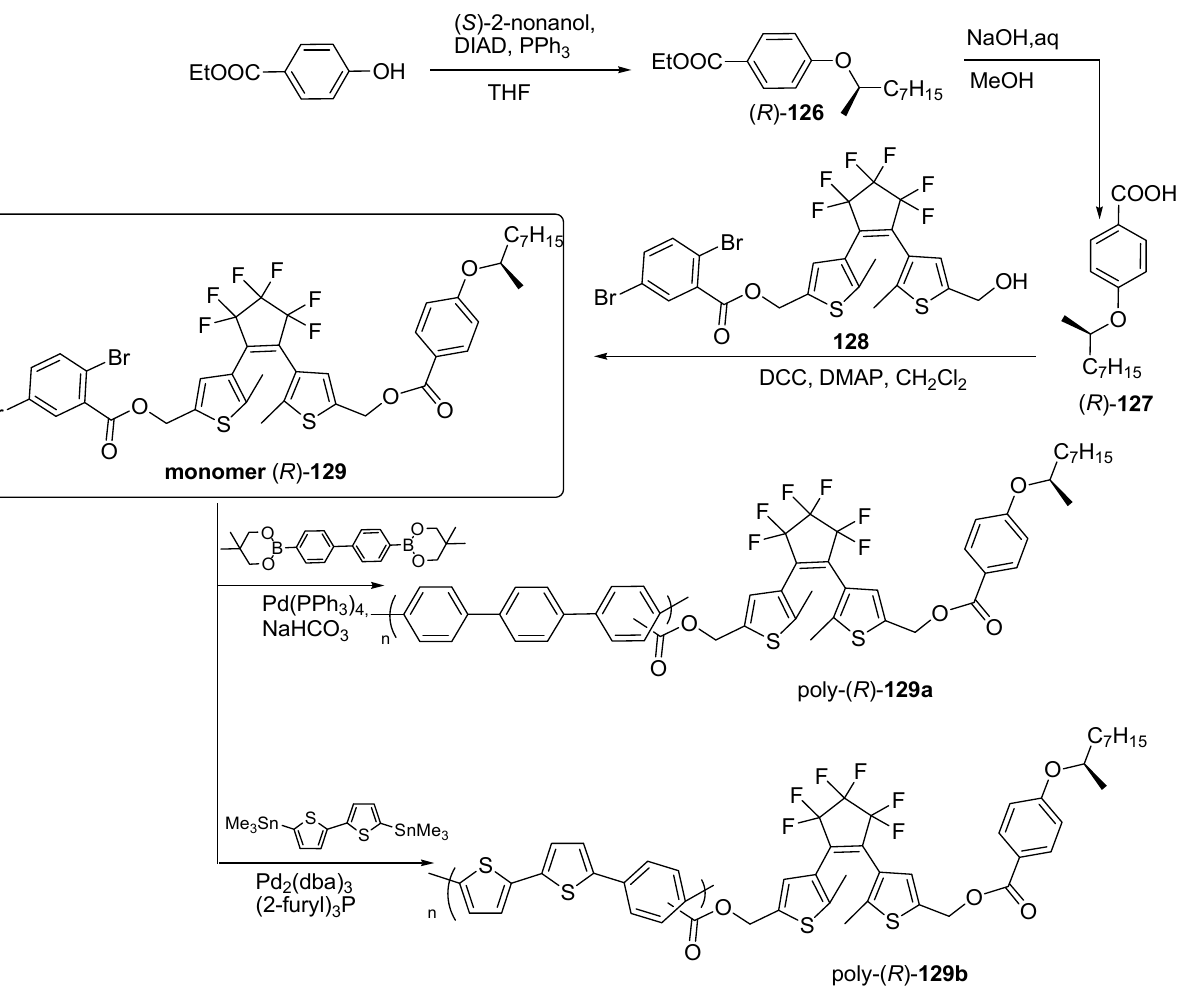
Scheme 38. Synthesis of monomer ( R )- 129 and the routes to the copolymerizations via the Suzuki or Stille coupling